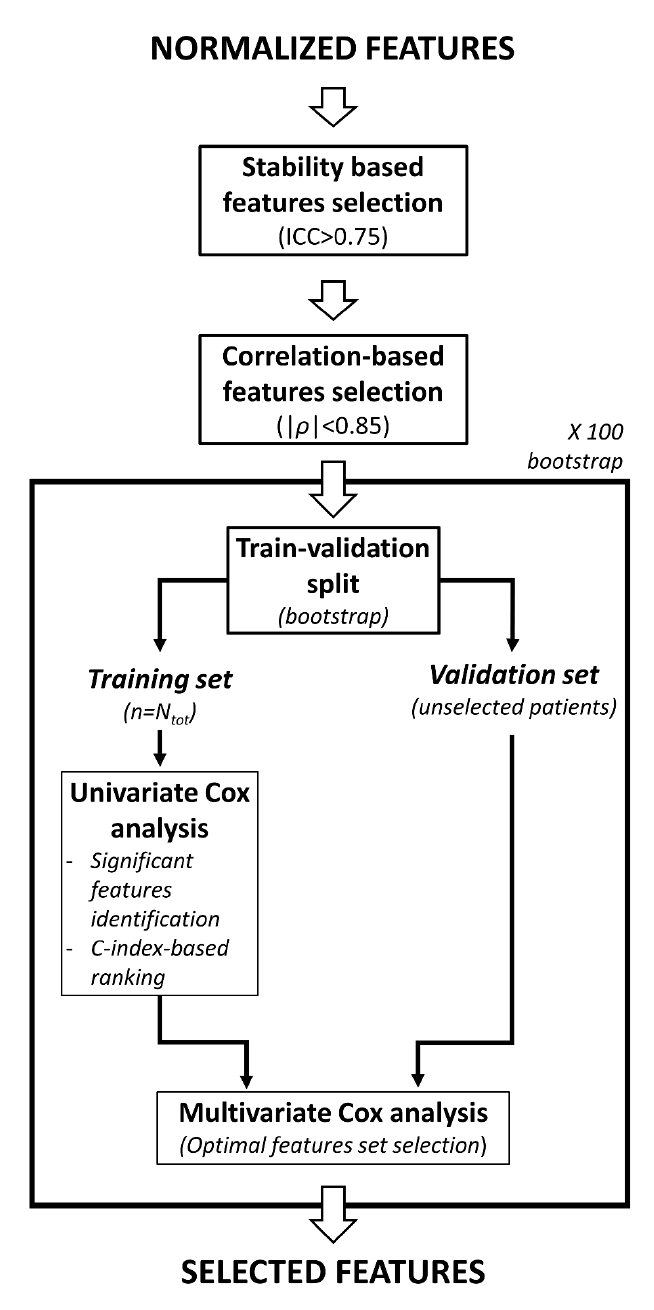
Figure 7. Workflow representing the features selection pipeline used in this study. The N tot in the figure refers to the number of subjects in the entire dataset.